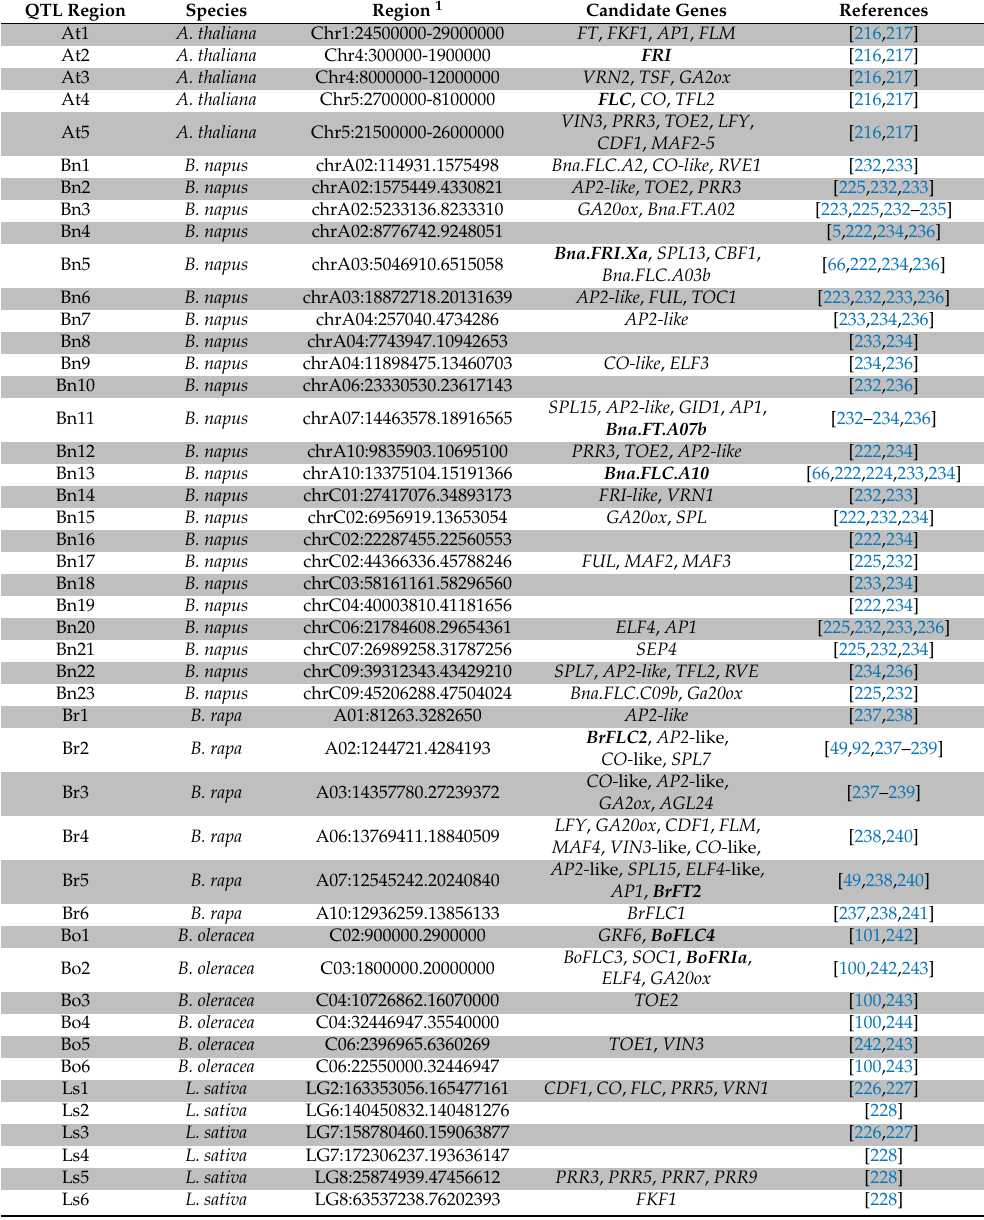
Table 4. Flowering-time related QTL regions for A. thaliana, B. napus, B. rapa, B. oleracea and L. sativa with candidate flowering-time genes within these QTL